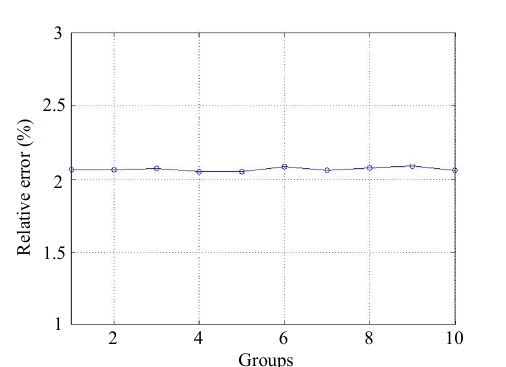
Fig. 12 Relative errors with 10